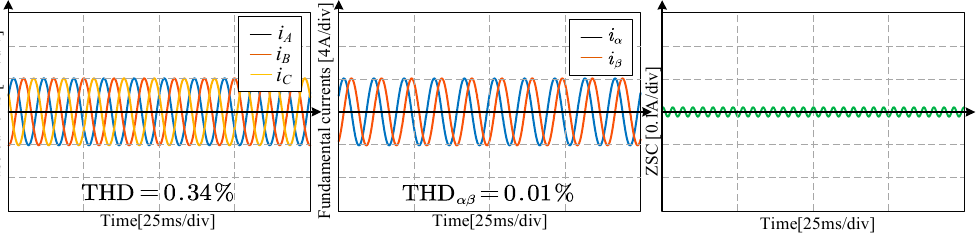
Figure 17. Simulation steady-performance of proposed FW-DFVL under 1200 rpm reference.